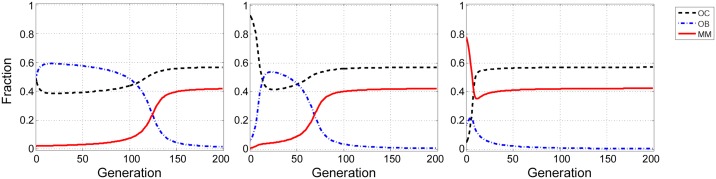
Effect of initial frequencies on the dynamics for scenario 1.Different initial frequencies of OC, OB, and MM cells do not change the final state of the population. Parameters as in Fig 2.